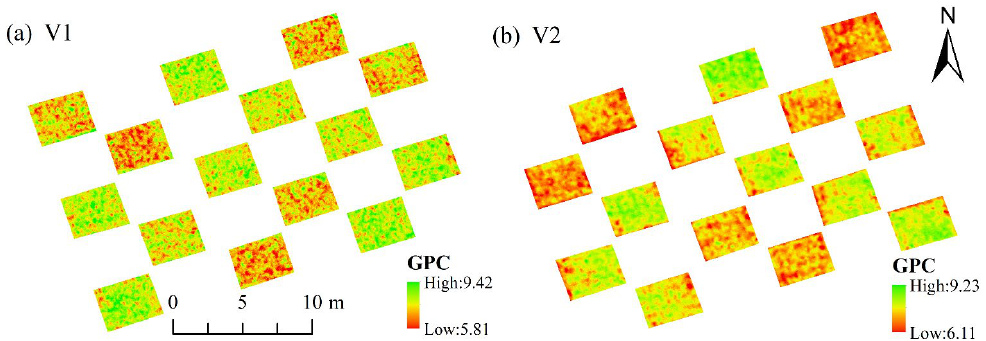
Figure 12. Grain protein content (GPC) monitoring maps of the study area in 2020 based on ( a ) a photochemical reflectance index (PRI)–leaf area index (LAI)–plant nitrogen accumulation (PNA) three-dimensional index model at the heading stage; and ( b ) a red edge chlorophyll index (CI red edge )–LAI–PNA three-dimensional index model at the panicle initiation stage.